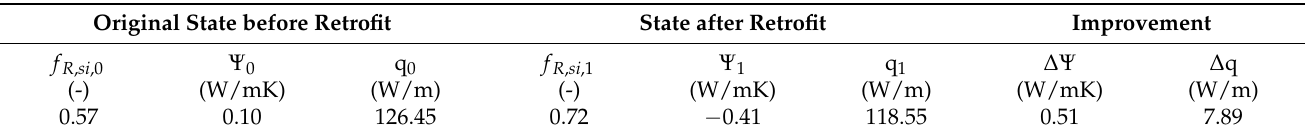
Table A17. Quantifiable results of the thermal bridge retrofit of a window reveal (ThermCad thermal bridge simulation calculation).